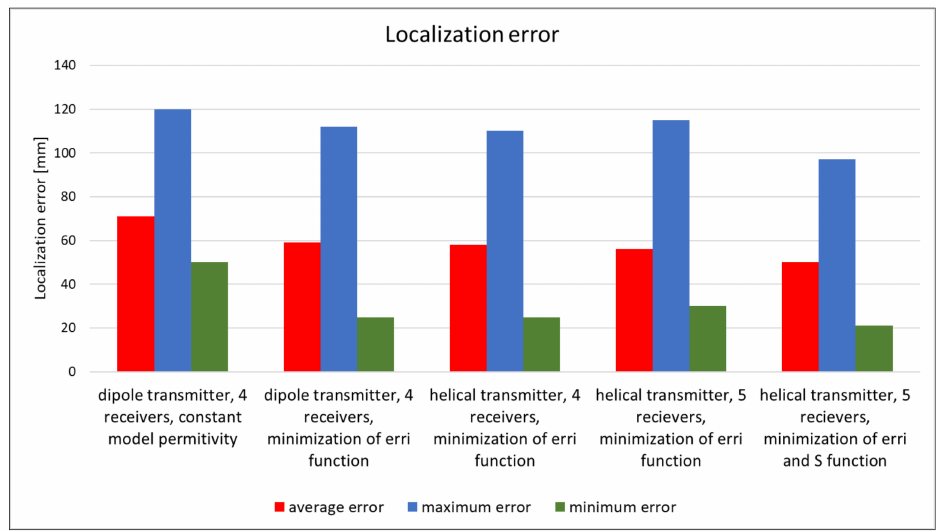
Figure 5. The impact of capsule antenna type, number of receivers and algorithm version on localization error achieved for simulation in XFdtd Remcom and heterogenous human body model [17,19].